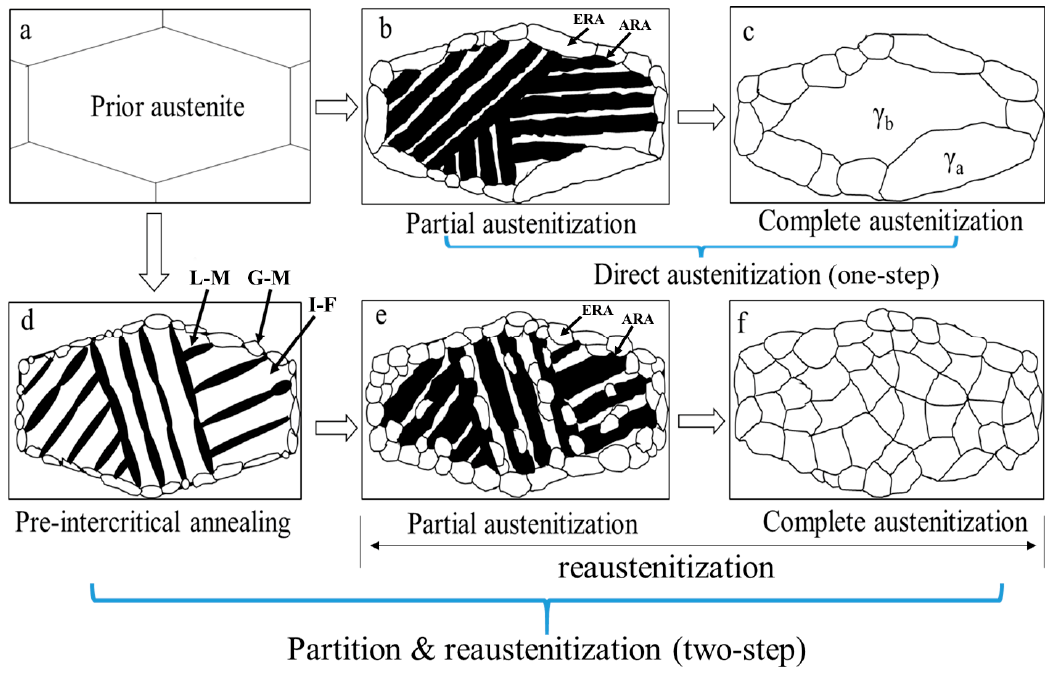
Figure 8. Schematic of direct austenitization ( a – c ) or partition and reaustenitization ( a , d – f ) for hot rolled experimental steel. ERA: equiaxed reversed austenite; ARA: acicular reversed austenite.